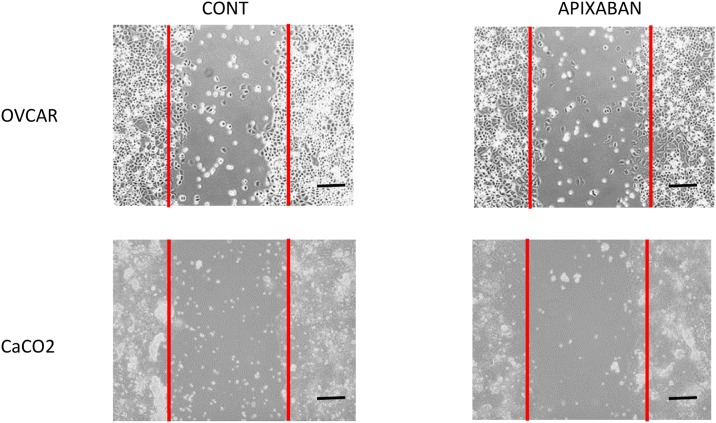
Fig 6 shows an example of cell migration after 24-h from scratch test in controls and cells pre-incubated with Apixaban (96-h, 5μg/ml) in OVCAR3 and CaCO-2 cells.Lines represent the edges of the scratched areas. Bars represents 100μm; magnification 10x.